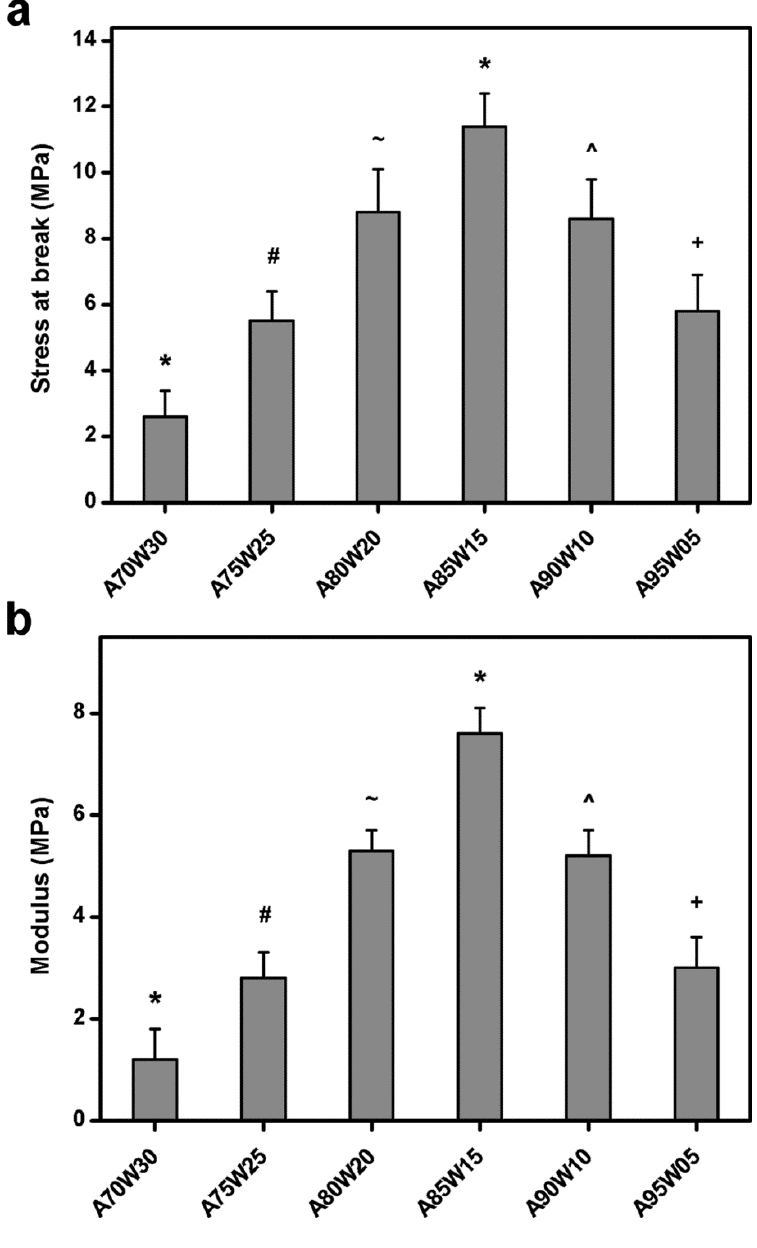
Figure 2. Mechanical properties of EDC cross-linked HA membranes as a function of solvent composition. ( a ) Tensile stress; ( b ) Young’s modulus. Values are mean ± SD ( n = 8). * P < 0.05 vs. all groups; # P < 0.05 vs. all groups, except A95W05; + P < 0.05 vs. all groups, except A75W25; ~ P < 0.05 vs. all groups, except A90W10; ^ P < 0.05 vs. all groups, except